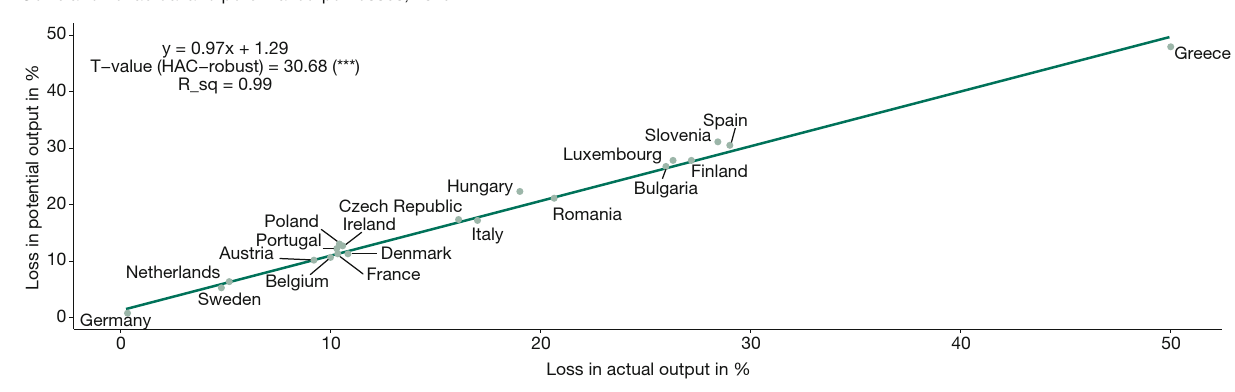
Figure 2 Downward revisions in potential output in pre-COVID-19 times Correlation of actual and potential output losses,